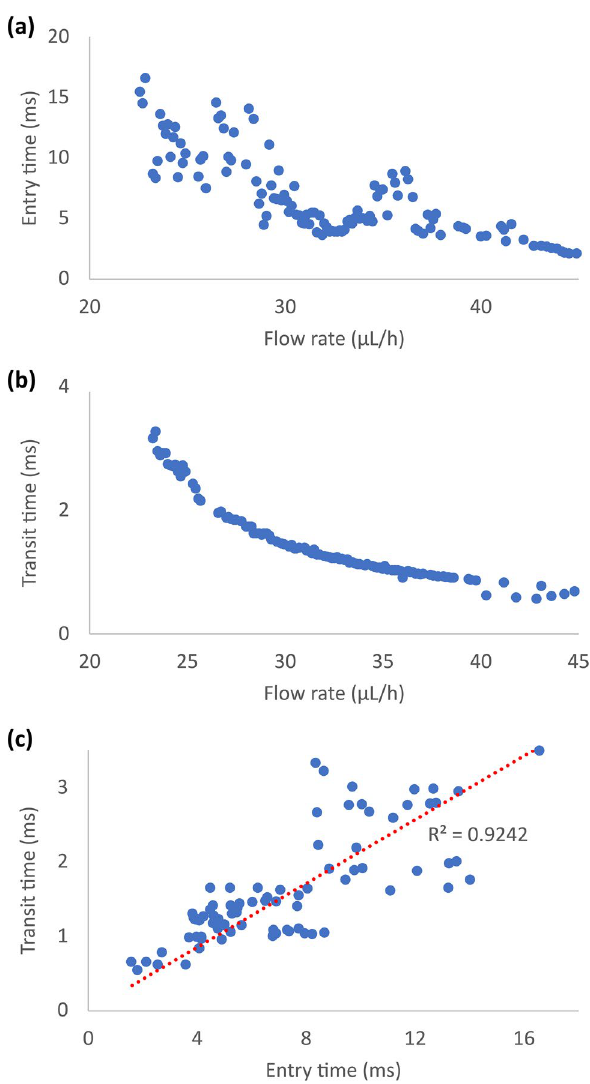
Figure 8. Effects of flow rate on the calculated entry time ( a ) and transit time ( b ) of a lung cancer cell in a microfluidic constriction as well as relationship between entry time and transit time at different flow rates ( c ). Simulations were performed using the validated spring-network model of the cell with accurately identified parameters. Both entry time ( a ) and transit time ( b ) generally follow a power law decrease with flow rate and they have a linear relationship with each other as the flow rate changes ( c